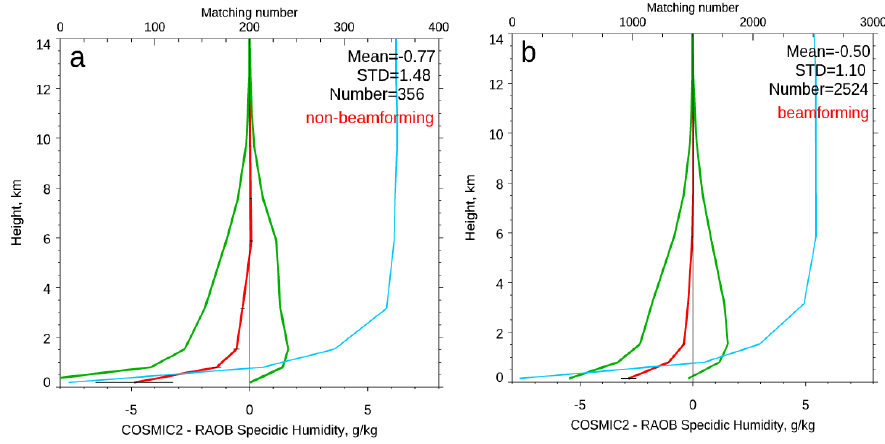
Figure 9. Similar to Figure 8 but for COSMIC-2–RS41 water vapor pairs where COSMIC-2 data are from ( a ) the non-beamforming period and ( b ) the beamforming period.